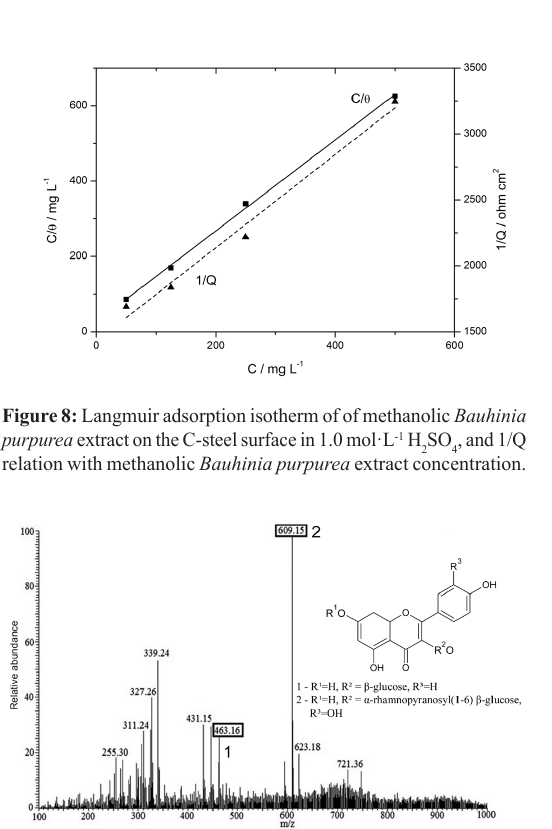
Figure 7: SEM micrograph (2000x) of C‑steel immersed in 1.0 mol·L -1 H Bauhinia purpurea extract (B).